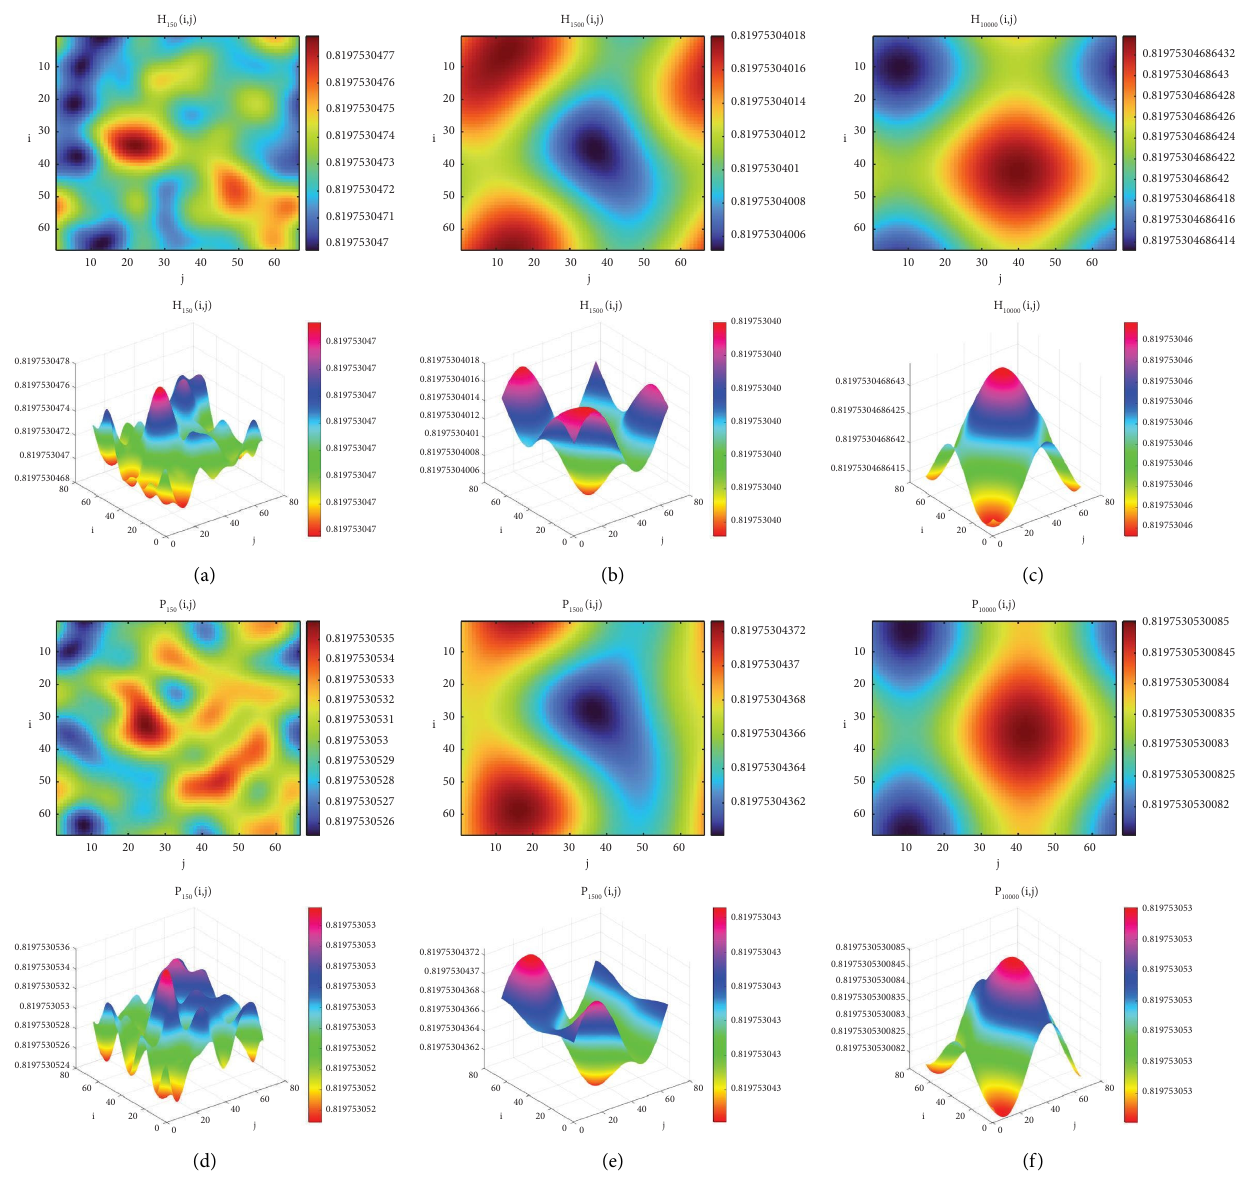
Figure 20: R � 2 ,k � 1, c � 0 . 8, σ ∗ � 0 . 278655, σ � σ ∗ , ( d case of Corollary 3(6), the pure Neimark-Sacker instability occurs, parasite and host populations exhibit periodic oscillatory behavior in two-dimensional